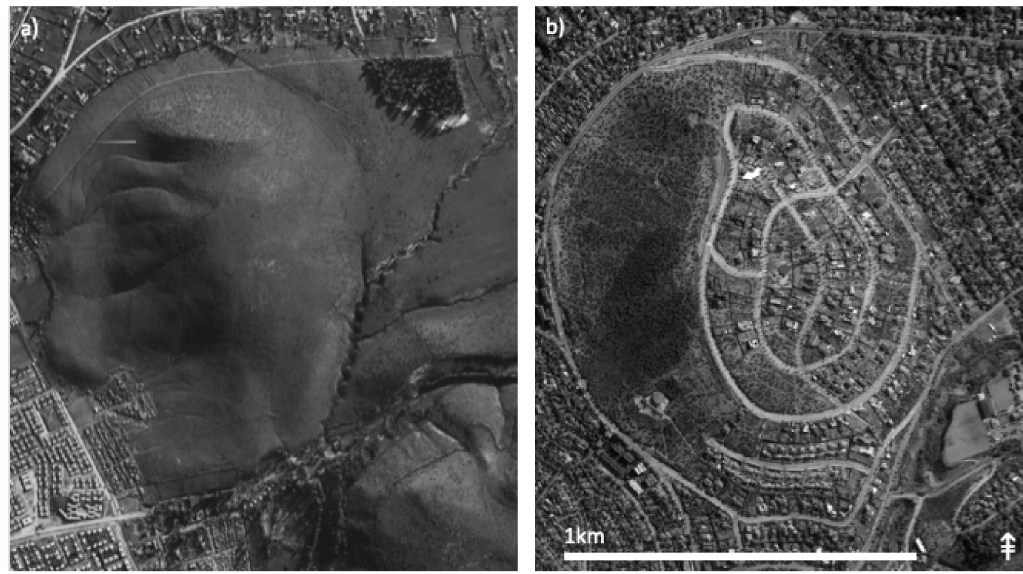
Figure 4. Santiago de Chile. Area east of city centre in ( a ) 1972 and ( b ) 2006, showing hill and rivers transformed by urbanisation. (Data: Table